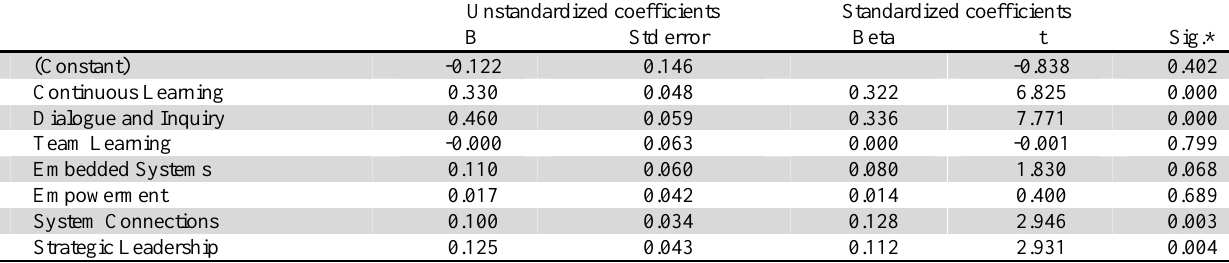
Regression equation- knowledge utilization and learning organization dimensions Unstandardized coefficients